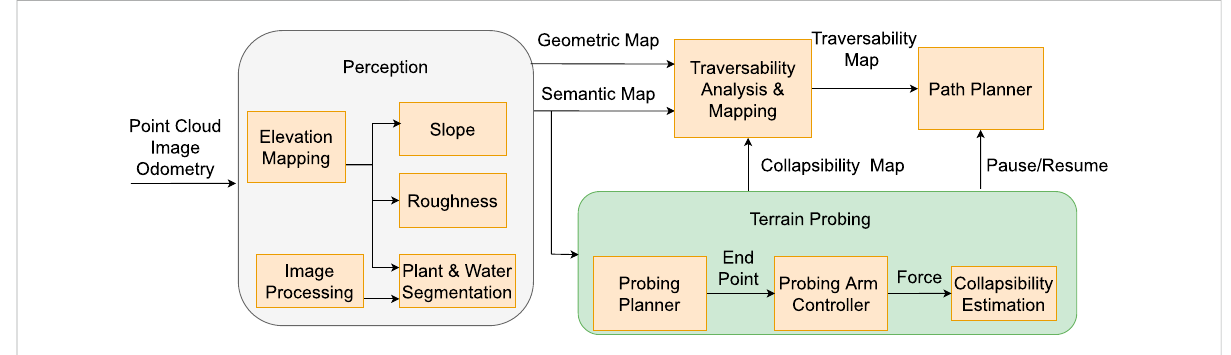
FIGURE 1 Framework of traversability analysis with vision and terrain probing: Perception evaluates geometric properties (slope-roughness) using an elevation map. Image processing using deep neural networks is used to segment plants and water. In the terrain probing section, a probing planner